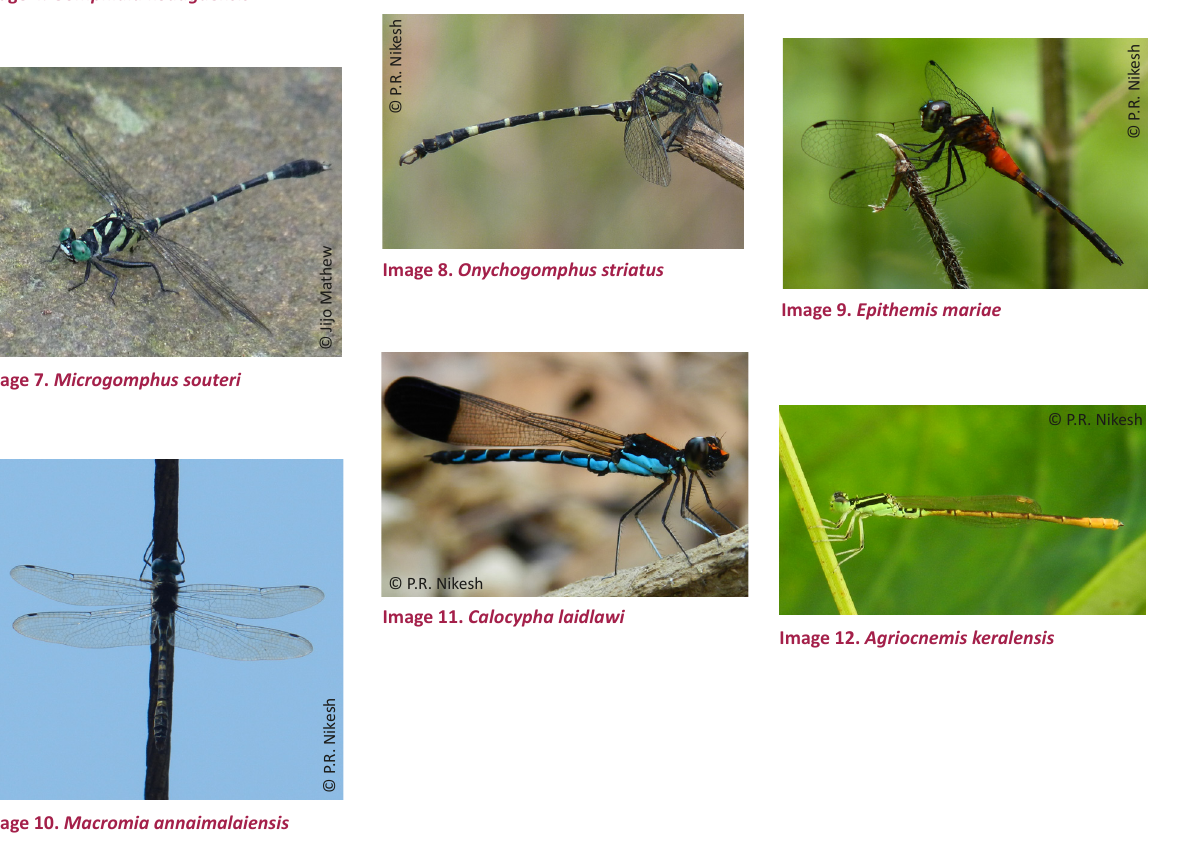
Image 4. Gomphidia kodaguensis